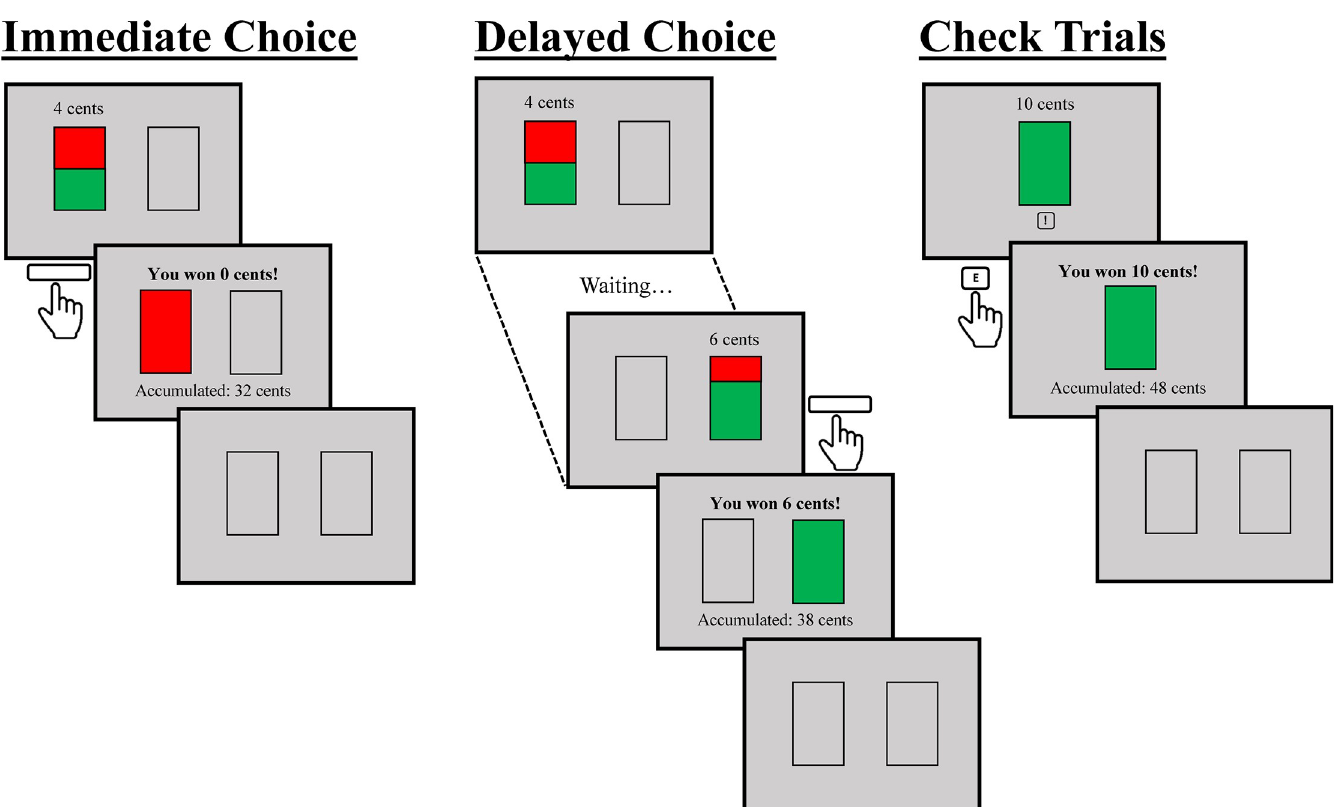
Fig 1. Sequence of the decision-making task. Left: Trial in which the immediate choice is selected, but no reward is won. Centre: Trial in which the delayed choice is selected, and the reward is won. Right: Check trial to monitor the participant’s engagement, in which an appropriate response is provided, and the reward is won.